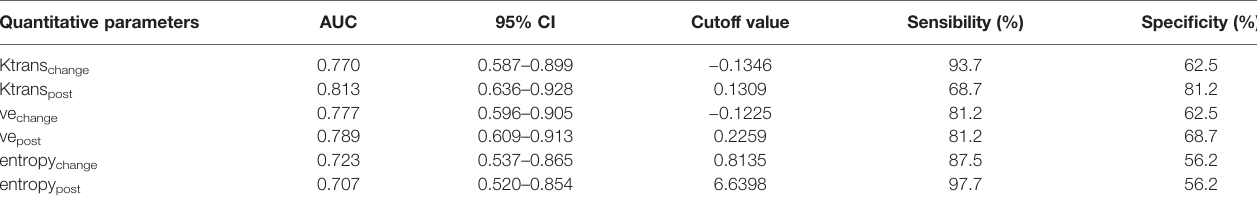
TABLE 3 | Diagnostic ability of vascular permeability parameters and texture parameters according to response groups. Quantitative